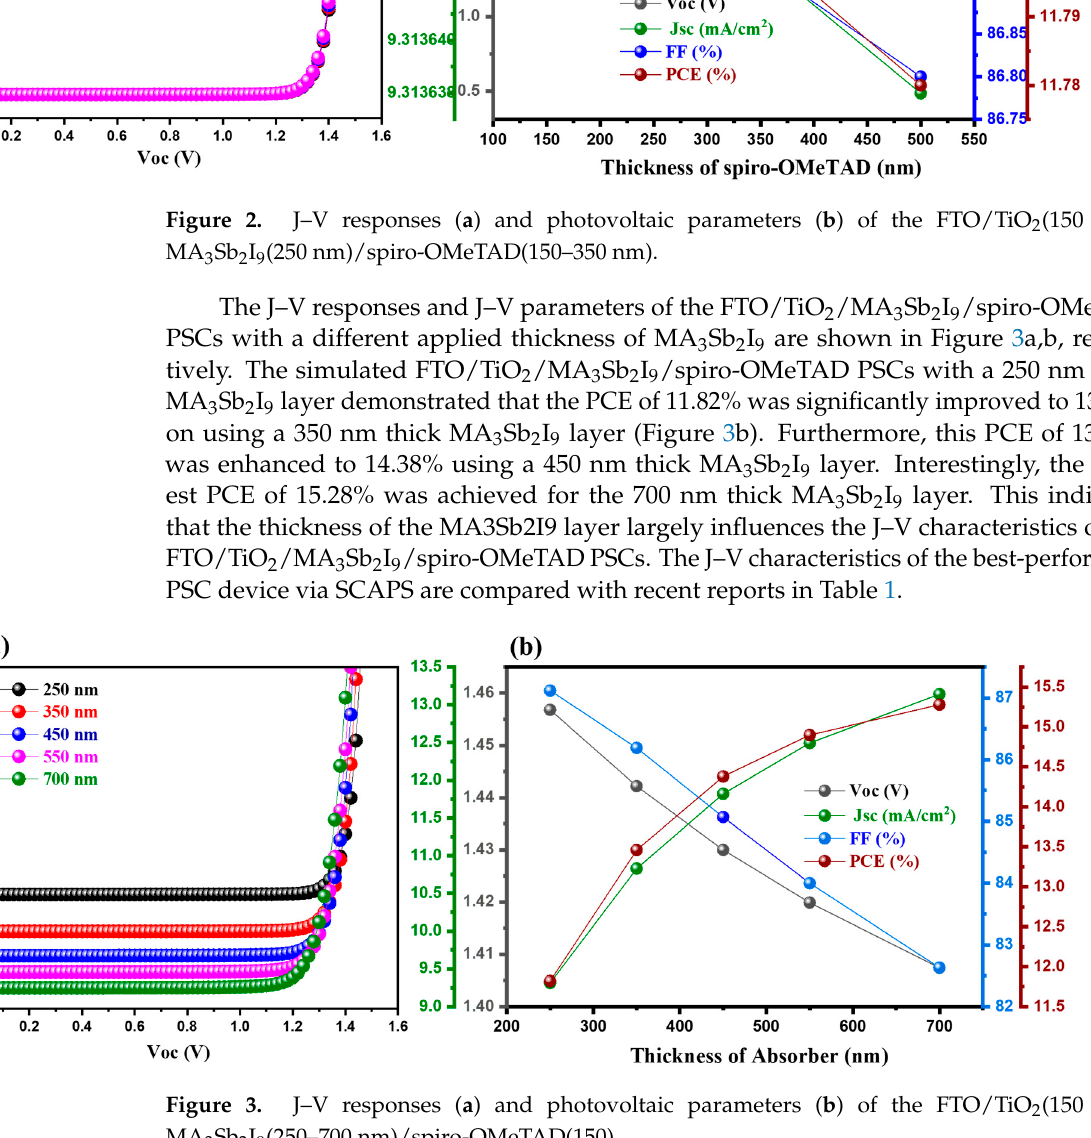
Table 1. Comparison of the Voc, Jsc, F.F., and PCE of the simulated MA 3 Sb 2 I 9- based PSCs with the recently reported articles.